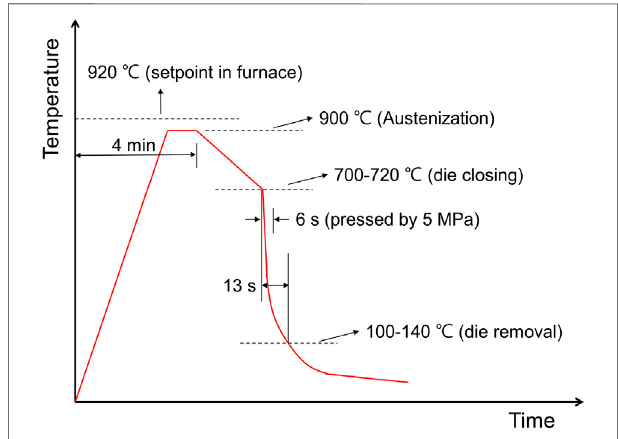
Frontiers in Materials |